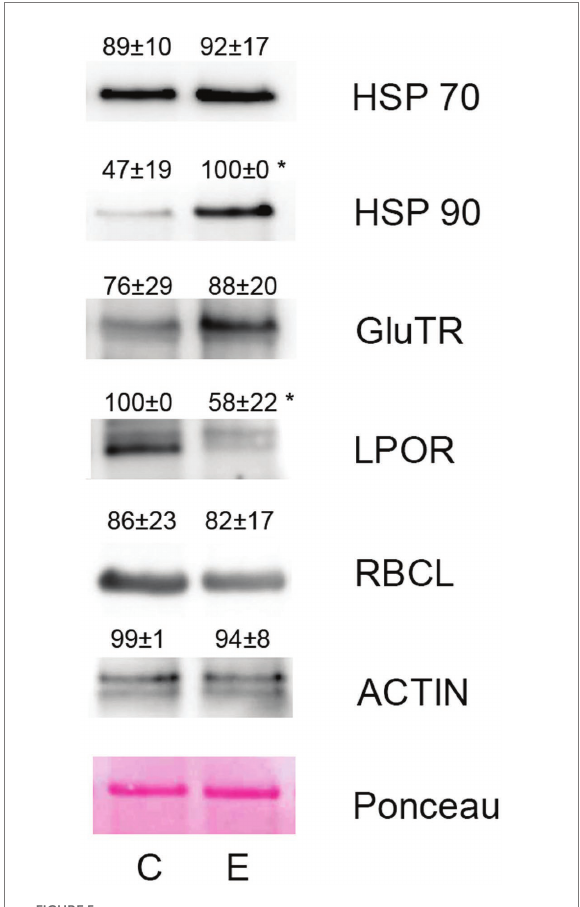
FIGURE 5 Western blotting of selected proteins involved in heat stress response and chlorophyll metabolism in Arabidopsis thaliana . The same protein amount was separated in 10% (v/v) SDS-PAGE and subjected to Western blot analysis. Antibodies against HSP70, HSP90, GluTR, LPOR, RbcL, and actin were used. The representative blots from three independent isolations are shown. The quantification of chemiluminescence signal is shown above the corresponding band. Means ± SD. C, control plants; E, etherized plants. Asterisks (*) denote significant differences at p < 0.05 (Student’s or Welch’s t -test), n = 3.